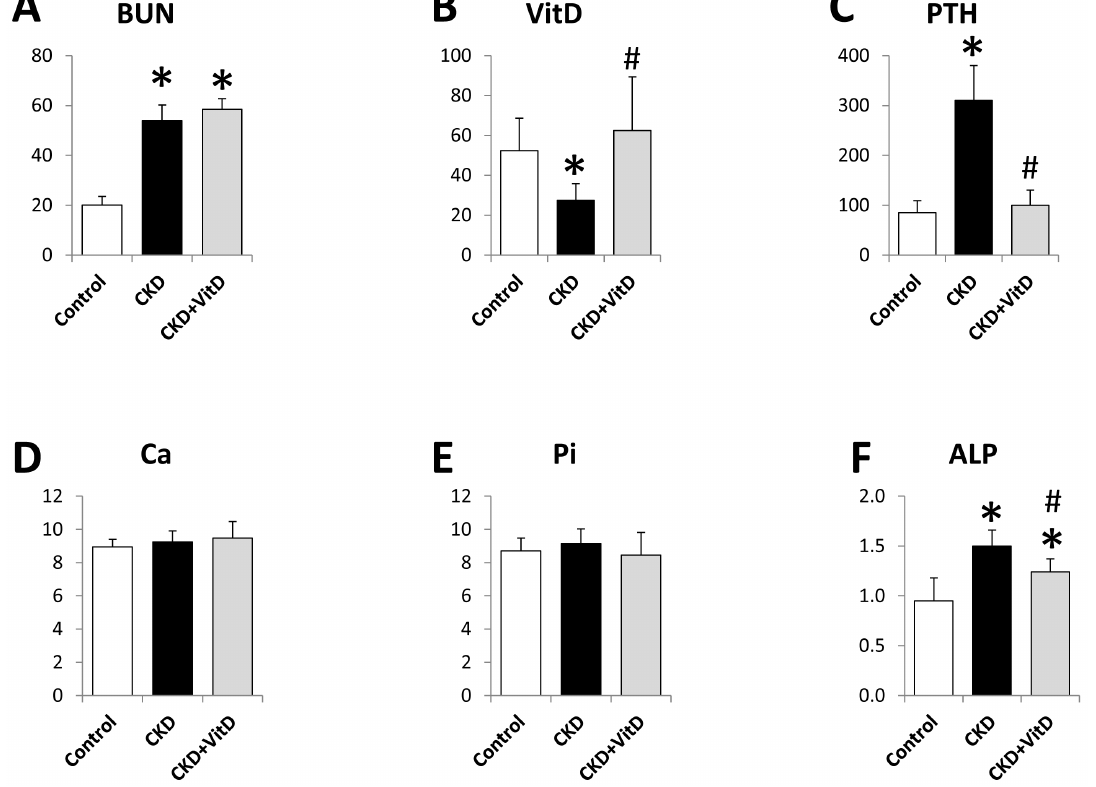
Figure 2. Serum biochemical measurements. (A) Serum BUN; (B) Serum Vitamin D; (C) Serum PTH; (D) Serum calcium; (E) Serum phosphate, and (F) Serum ALP activity. *: p , 0.05 vs Control; # : p , 0.05 vs CKD.